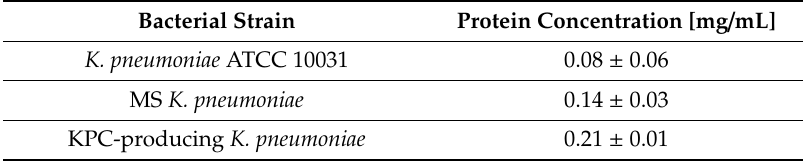
Table 3. Protein concentration of OMVs purified from di ff erent strains of K.